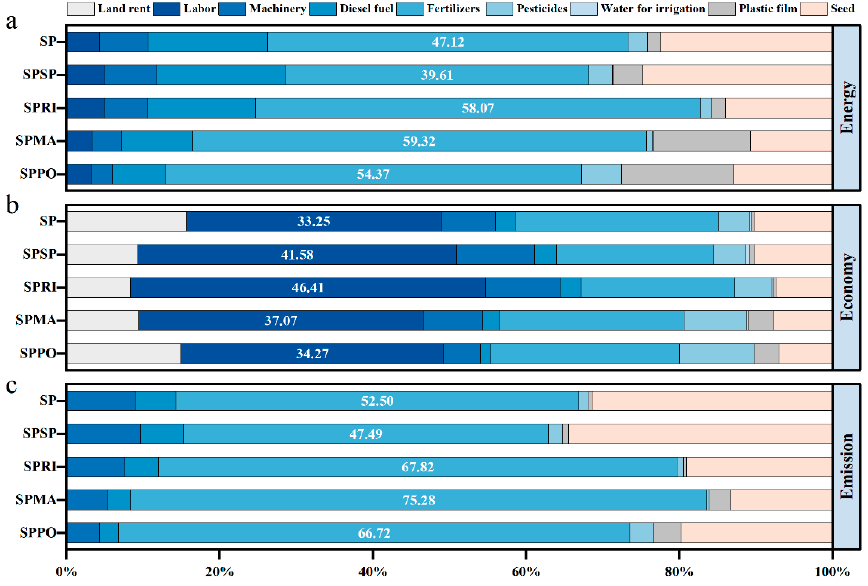
Figure 4. The percentage of each input source to the total energy inputs ( a ), economic inputs ( b ), and greenhouse-gas emissions ( c ) for mono cropping of sweet potato (SP); continuous cropping of sweet potato (SPSP); and rotation cropping system of sweet potato–rice (SPRI), sweet potato–maize (SPMA), and sweet potato–potato (SPPO).